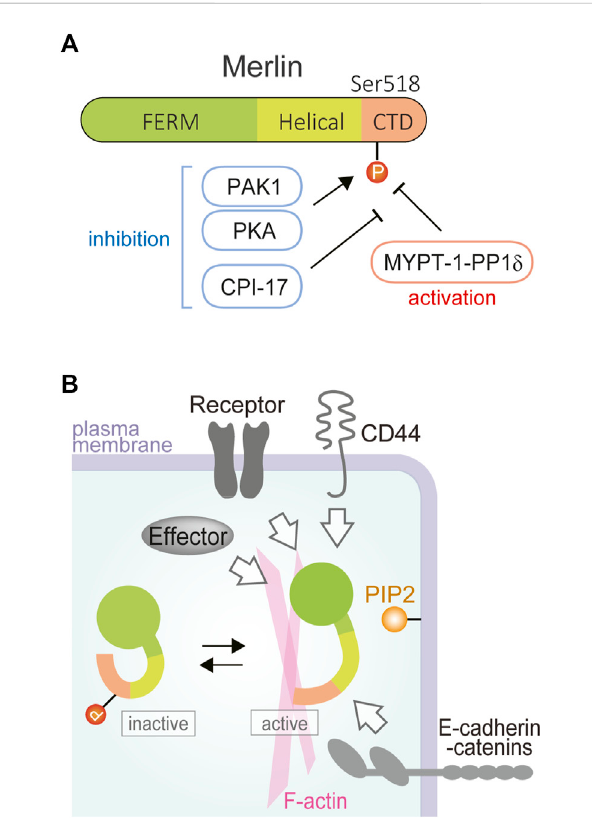
FIGURE 1 Domainstructureandactivation-inactivationofmerlin. (A) Merlin is composed of N-terminal FERM (4.1/ezrin/radixin/moesin) domain (green), a central alpha-helical domain (light green), and a C-terminal domain (CTD; orange). Ser518 is one of the major phosphorylation sites, phosphorylated with PAK or PKA and dephosphorylated with myosin phosphatase holoenzyme MYPT-1- PP1 δ that is encoded by PPP1R12A for the major regulatory subunit MYPT-1 and by PPP1CB for the catalytic subunit PP1 β / δ . (B) Merlin activation is regulated by many membrane-associated proteins such as receptor tyrosine kinases, CD44, and E-cadherin-alpha catenin. Merlin activation is thought to be induced by dephosphorylation and lipid binding. Merlin interacts with the plasma membrane and the cortical actin skeleton to exert tumor-suppressive